Question: Judging by this figure, is the value going up or going down?
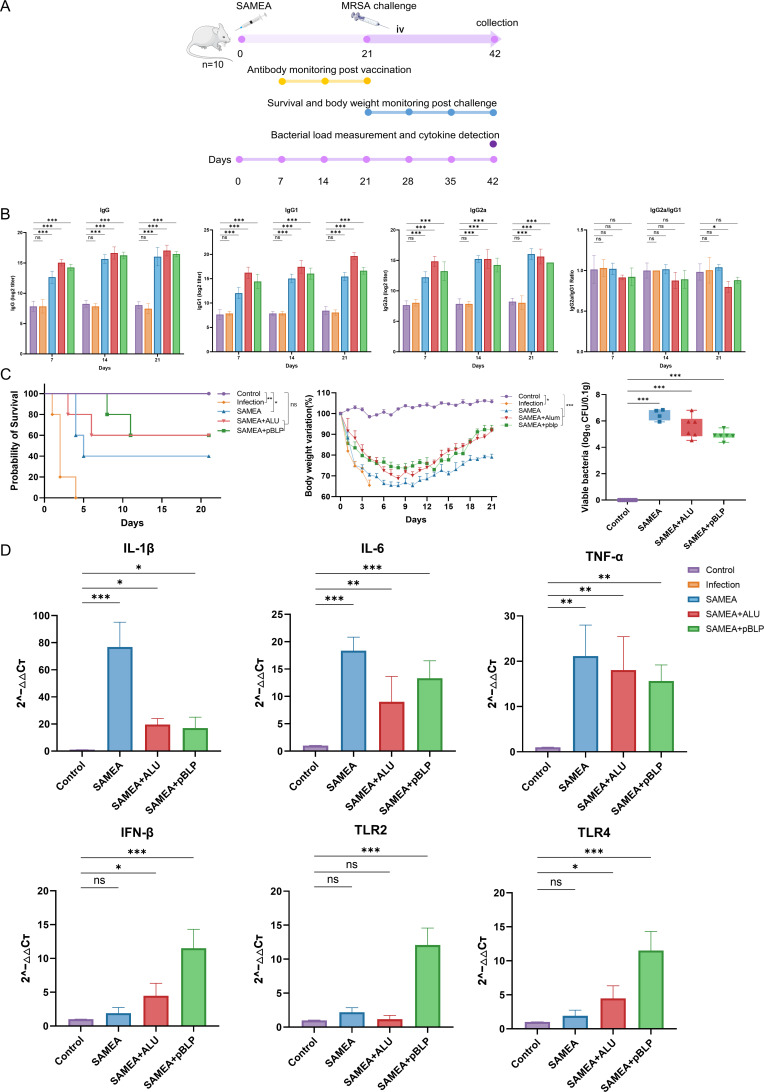
Answer: increasing